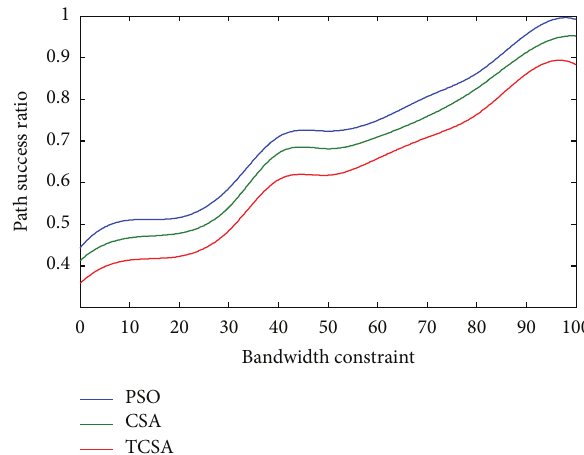
Figure 6: Plot between path success ratio and bandwidth.